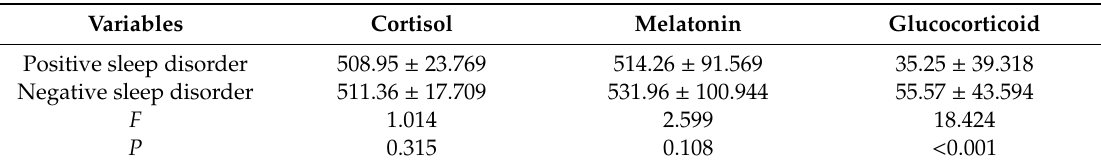
Table 5. Comparison of hormone levels between positive sleep disorder groups and negative sleep disorder groups ( ± S , mmol /